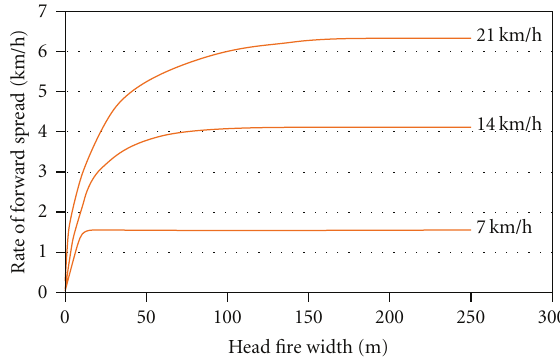
Figure 4: Fire spread rates in grass fuels were found to increase with the width of head fires and depend on the final spread rates determined by wind speed